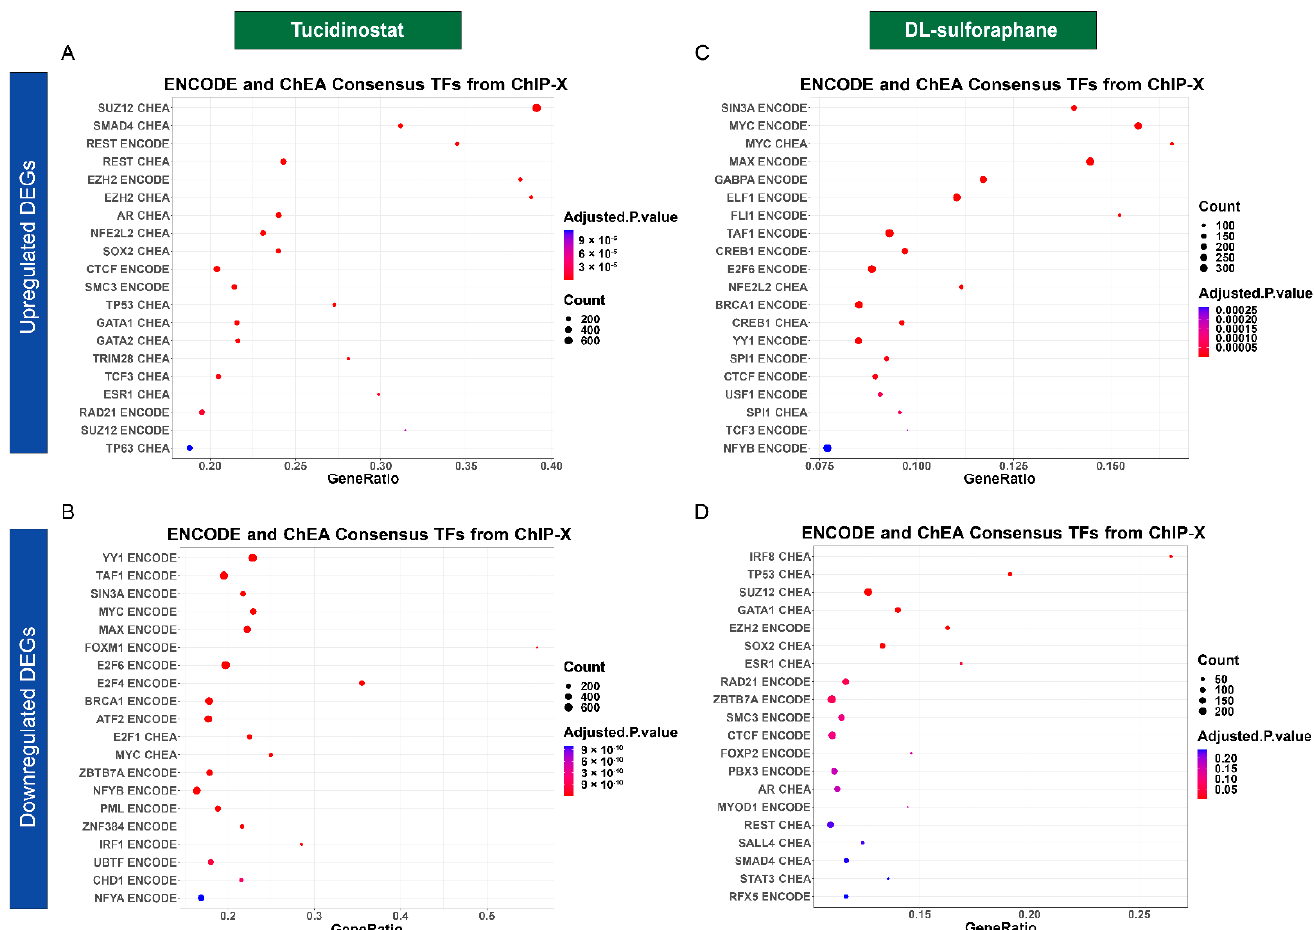
Figure 11. Transcription factors enrichment analysis . The dot plots showed the top twenty enrichment Terms for transcription factors associated with up DEGs ( A ) and down DEGs ( B ) in response to Tucidinostat treatment. ( C ) Transcriptional factors associated with up DEGs in response to DL-sulforaphane treatment. ( D ) Transcriptional factor enrichments associated with down DEGs in response to DL-sulforaphane treatment.